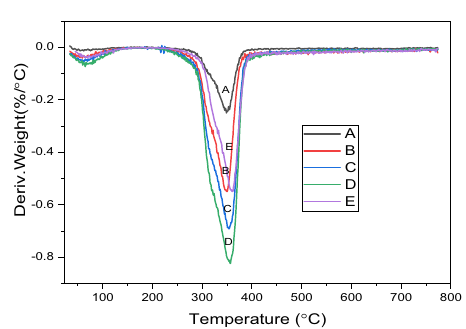
Fig. 1 FTIR spectra of different brands of arti fi cial teeth (Group A – E)